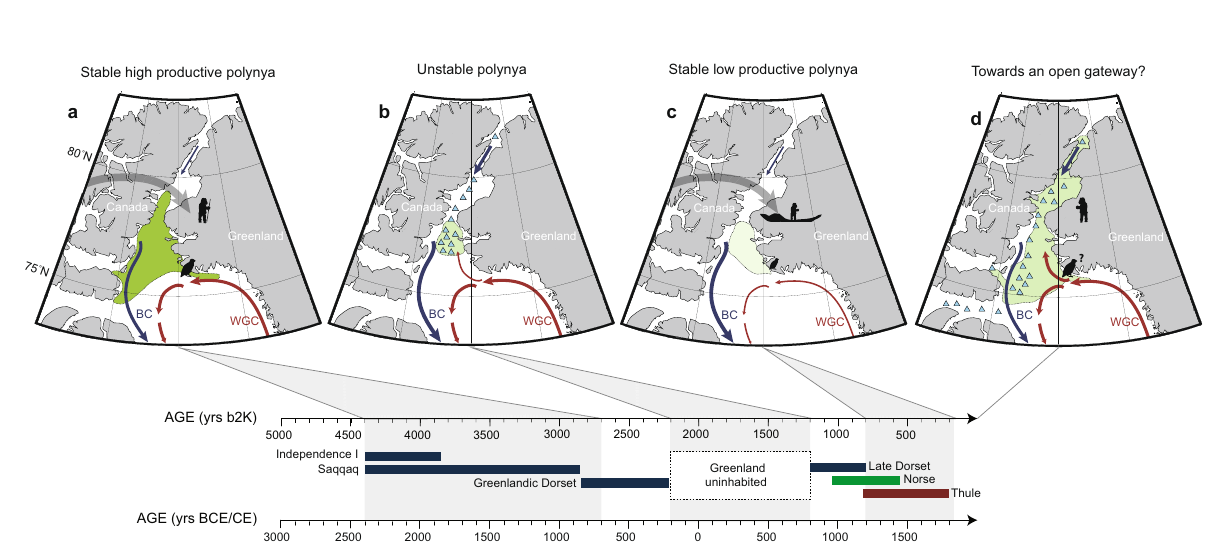
diatom assemblages (Supplementary Fig. 3). h Changes in Cadmium (Cd) to Titanium (Ti) ratios tracing the level of Cd-enrichment of the lake sediments by bird guano. The dark line shows a LOESS smoothed curve. i δ 15 . j A combination of total cholesterol fl ux, and the ratio of cholesterol to cholesterol plus β -sitosterol (greyscale) indicates relative bird colony size. RWP Roman Warm Period, DA Dark Ages cold period, MCA Medieval Climate Anomaly, LIA Little Ice Age, LD Late Dorset.